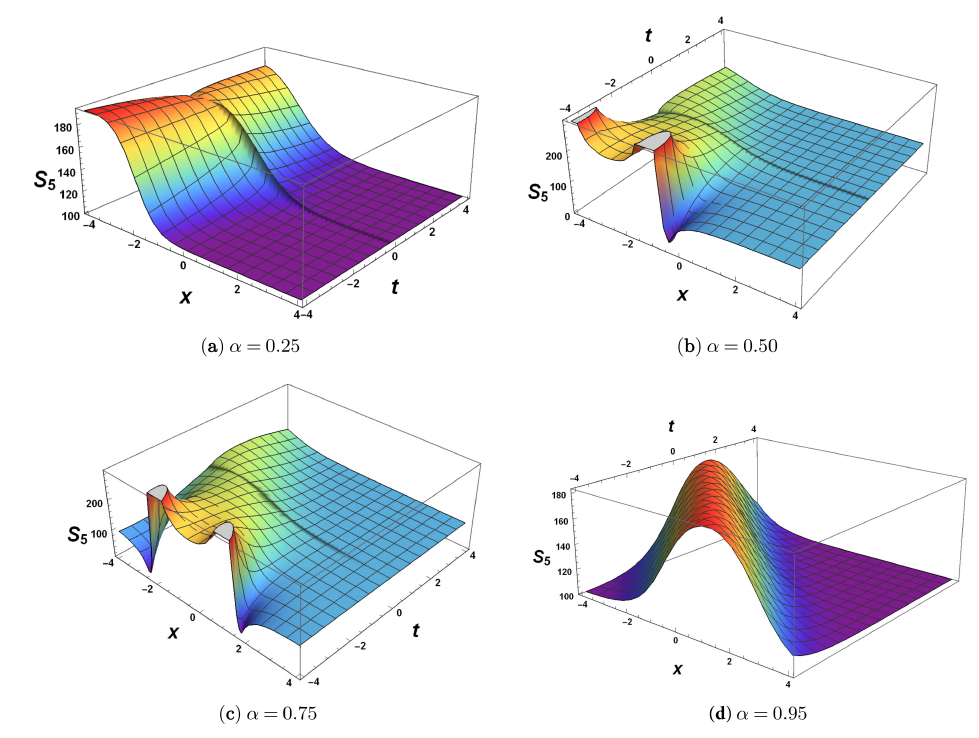
Figure 9. A 3D graphical representation for S 5